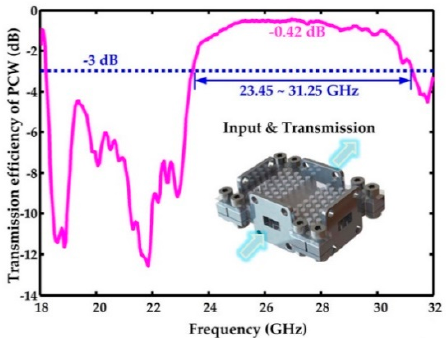
Figure 3. The variation of the transmission efficiency of the PCW with frequency.